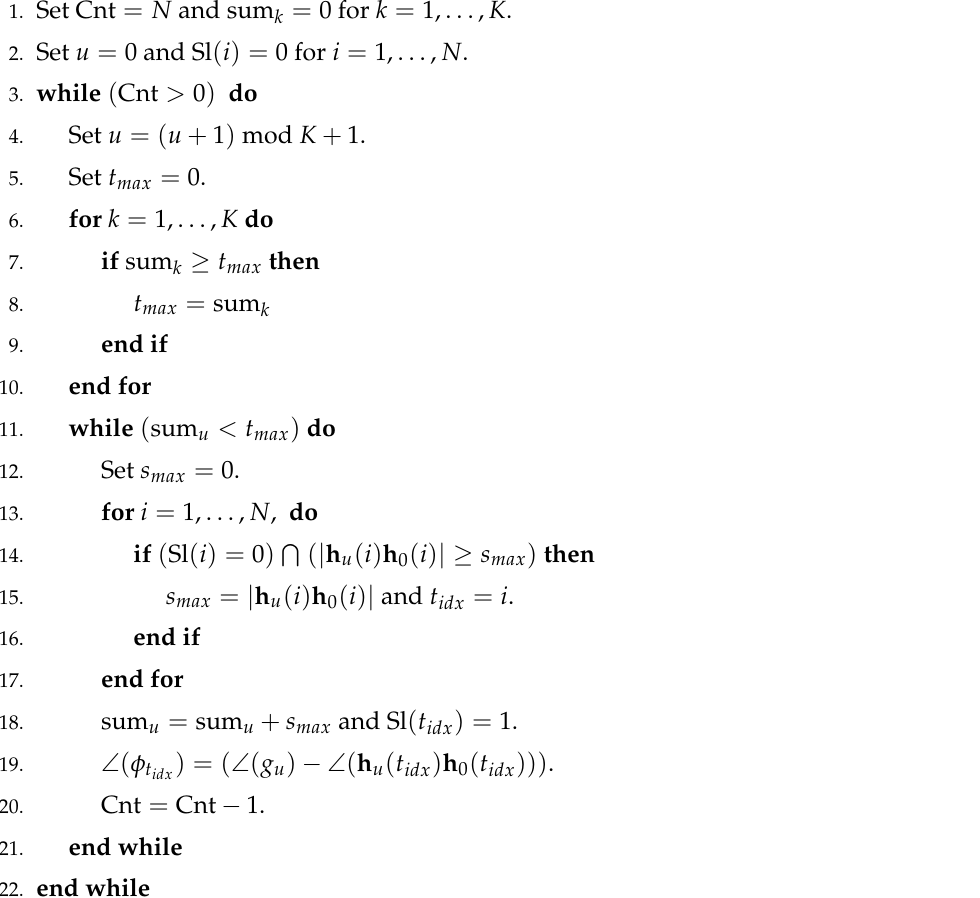
Algorithm 3 : Φ decision